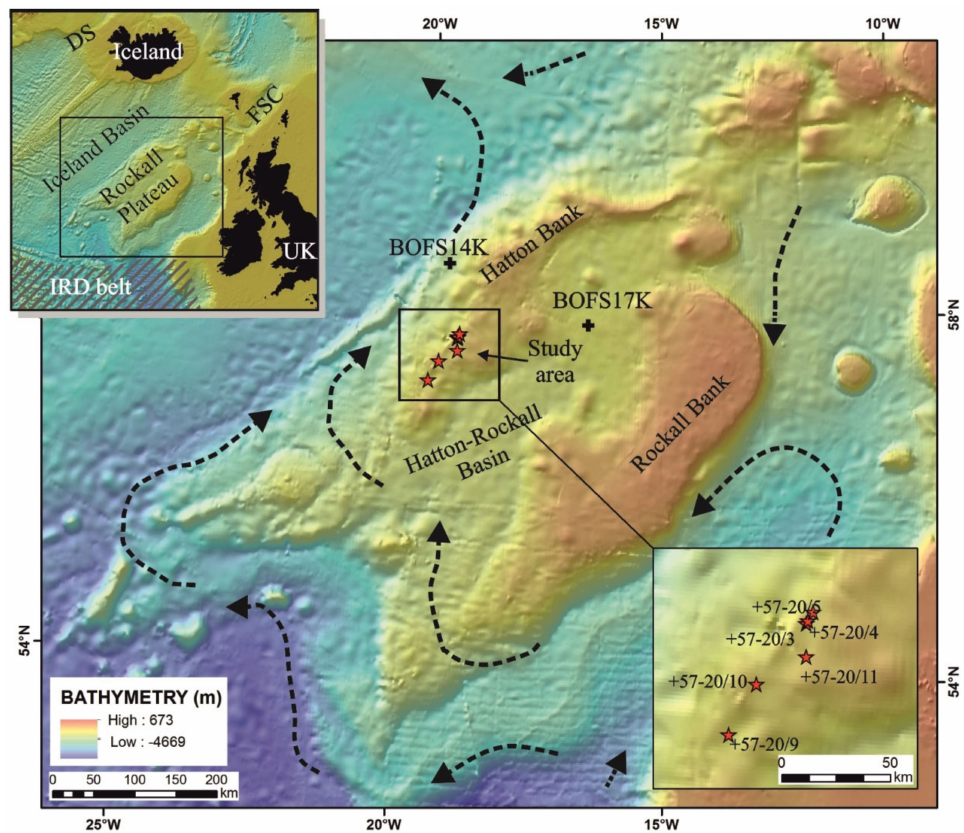
Figure 1. Local map showing the study area on Hatton Bank (northwestern part of the Rockall Plateau, NE Atlantic Ocean). Inset shows detailed location of the gravity cores. Dashed arrows show the main North Atlantic Deep Water (NADW) paths (of which Iceland–Scotland Overflow Water (ISOW) forms part) [9,16,17]. Locations of both sites BOFS14K and BOFS17K are shown (black crosses) [19–21]. Regional bathymetry from Amante and Eakins [22]. (UK: United Kingdom; IRD belt: Ice-Rafted Debris belt; DS: Denmark Strait; FSC: Faeroe–Shetland